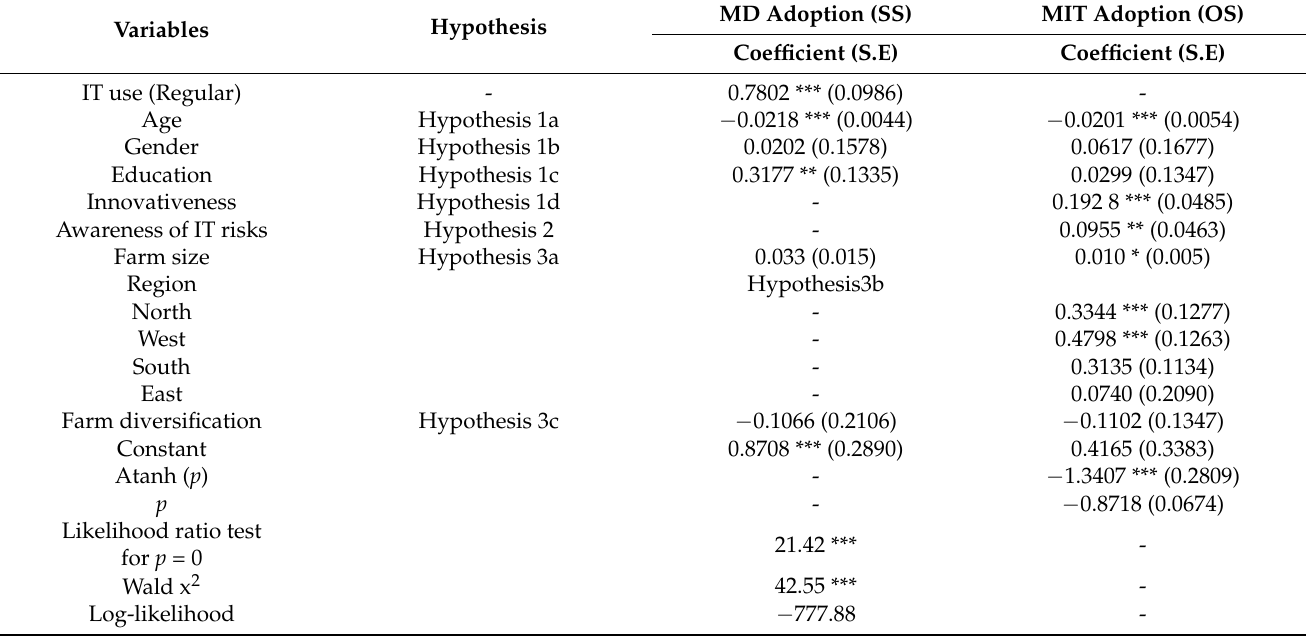
Table 2. Outcomes of the bivariate probit model, including sample selection of MDs and MIT adoption for wheat